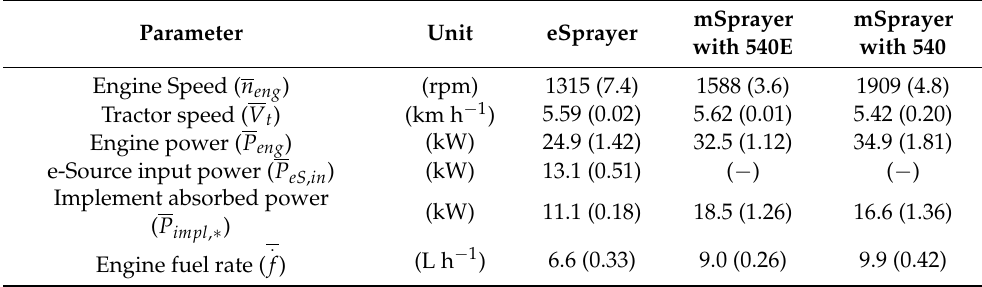
Table 10. Performance parameters obtained with fan speed ( n f ) set at 1300 rpm. In the brackets, the standard deviation of each parameter is reported.